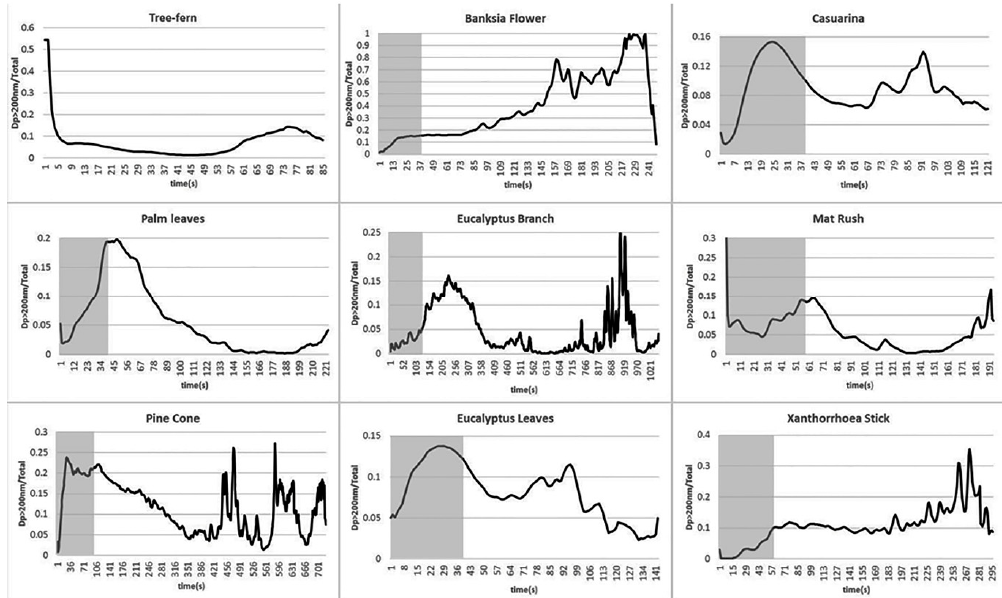
Figure 4. A ratio of the number of particles with diameter larger than 200 nm to the total number of the particle produced in combustion processes. Shaded areas represent the flaming phase of the combustion.